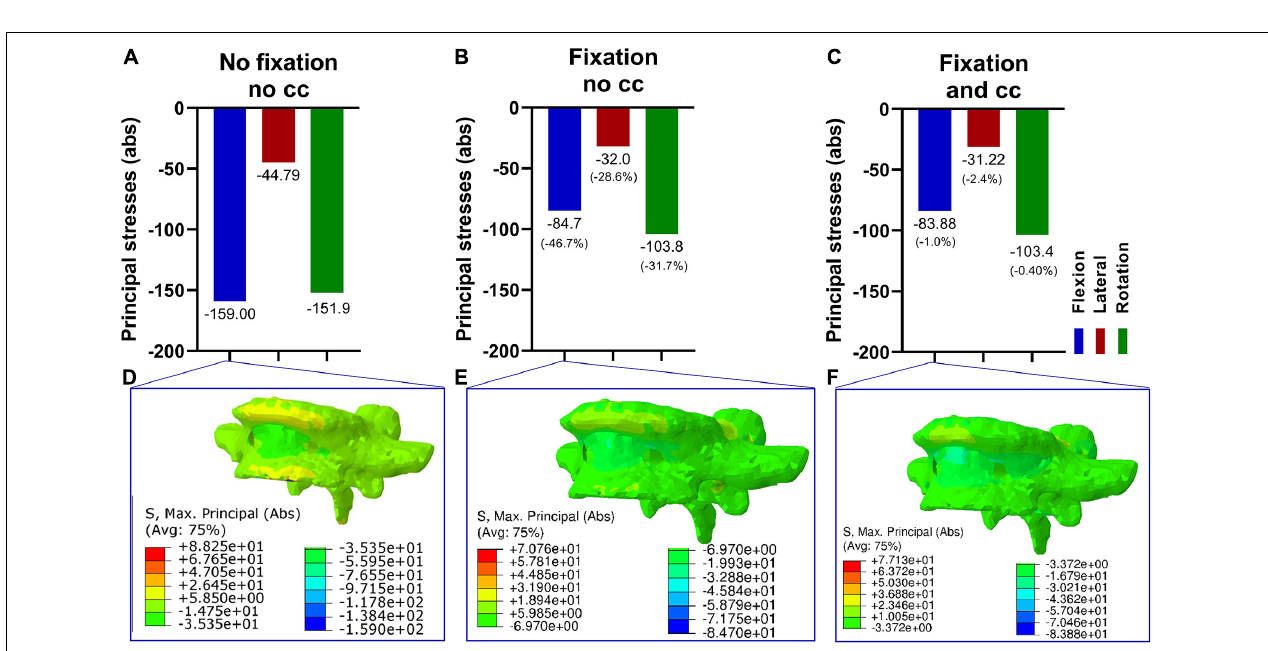
FIGURE 3 | Maximum principal stresses (absolute values) in the intervertebral disk L5/S1 (nucleus pulposus part) in three loading conditions (A–C) and corresponding stress distribution exemplarily depicted in the F/E situation (D–F) . Without fixation (A,D) , the resulting principal stresses were higher compared to the fixation procedure (B,C,E,F) . Upon fixation without cross connector (B,E) and with cross connector (C,F) , the differences appeared to be marginal.